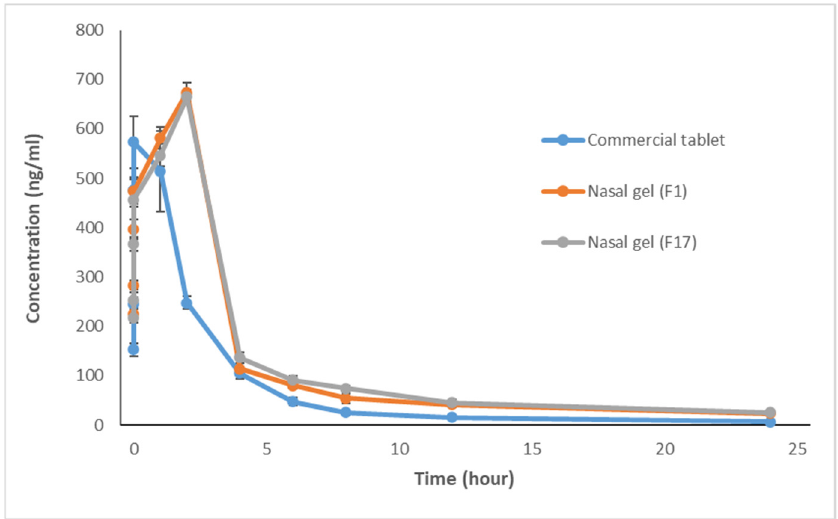
Figure 1. Mean plasma concentration-time profiles ± SD following administration of commercial oral tablets and in situ nasal gel formulations F1and F17 of ITO HCl in rabbits .